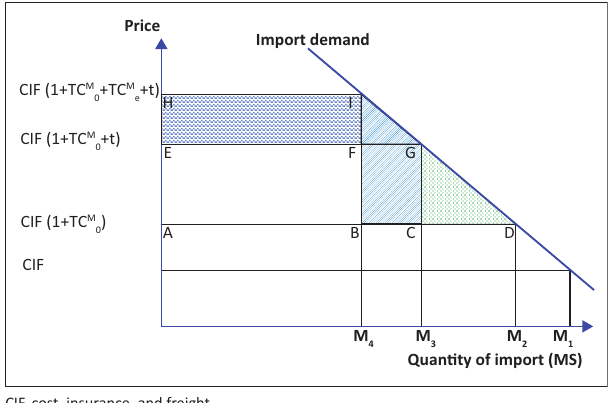
CIF, cost, insurance, and freight. FIGURE 1: Economic impact of tariffs and import compliance